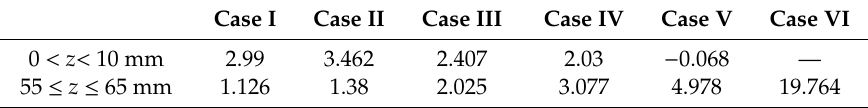
Table 2. The velocity gradient d U /d z (s − 1 ) in different regions.